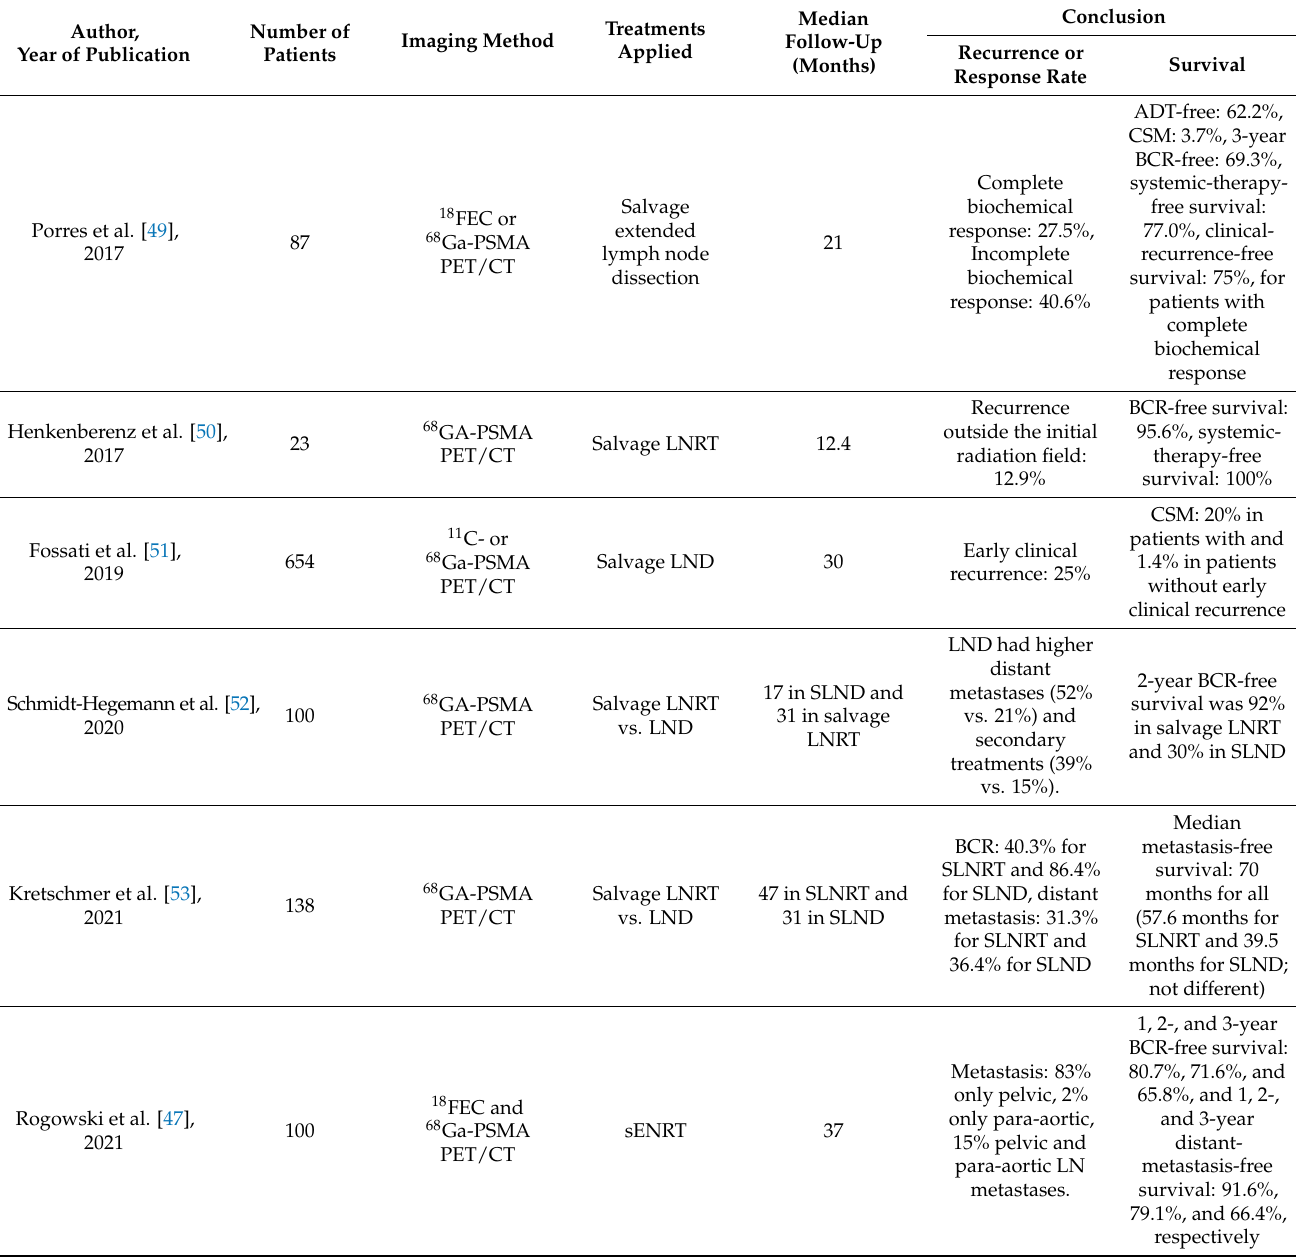
Table 1. The summary of studies reporting the treatment outcomes of PSMA-positive lymph nodes in patients with a recurrence of prostate cancer after primary treatment with radical